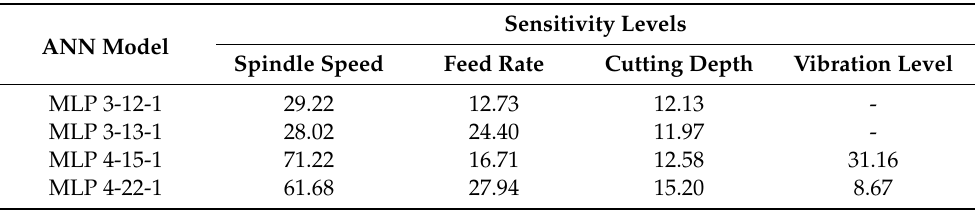
Table 5. Sensitivity level of the input variables of the selected neural network models.